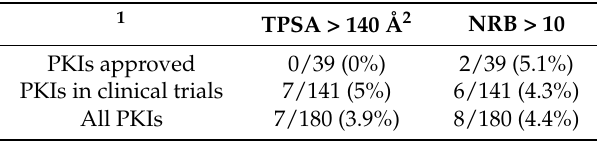
Table 3. Number of PKIs violating at least one Veber rule